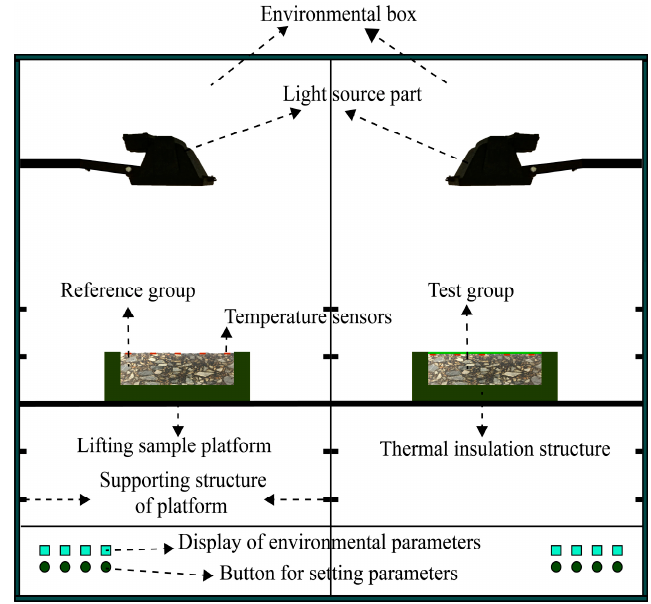
Figure 4. Test of CCL’s cooling effect.